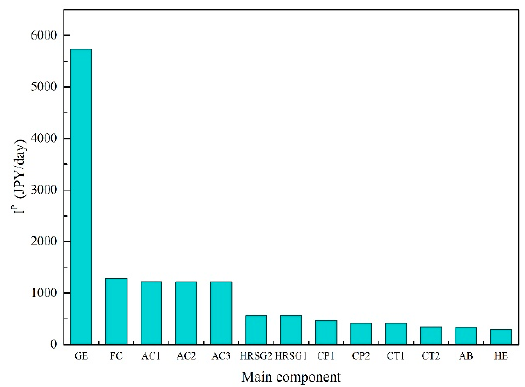
Figure 15. The potential failure cost importance index values of components of the CCHP system.